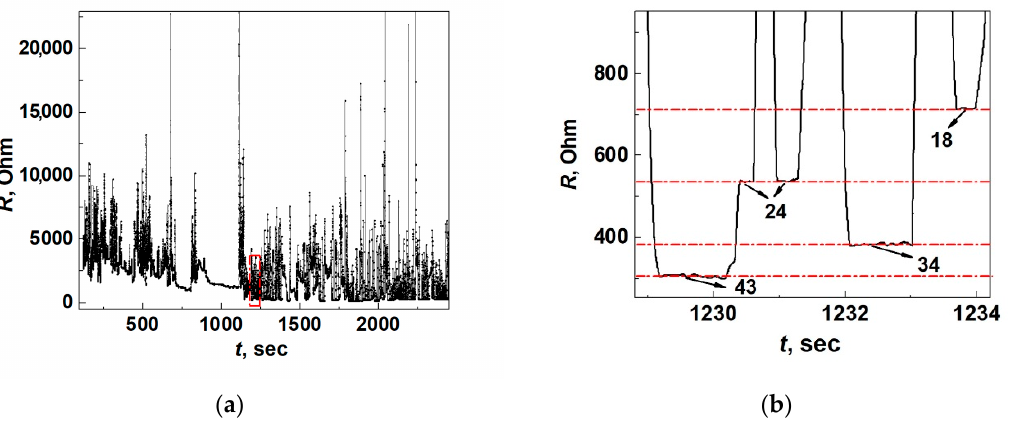
Figure 8. Dependence of resistance R on time t which reflects the transformations in the dendritic Yanson point contacts during the cyclic switchover effect in the ambient air. ( a ) General view of the curve R ( t ). ( b ) A large-scale image of the dependence R ( t ) in the area within the red rectangular section shown in ( a ). The number of conductance quanta that are associated with each specific metastable condition are indicated by arrows in ( b ).